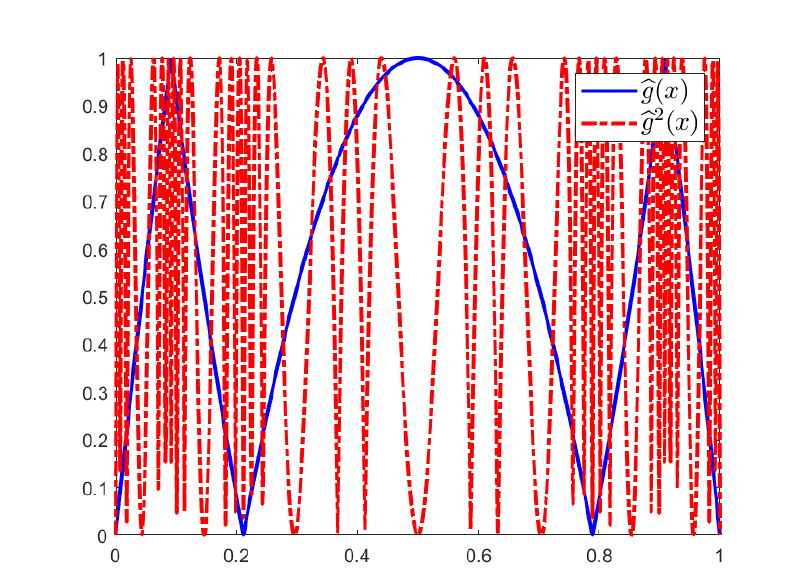
Figure 1. The function images of (cid:98) g and (cid:98) g 2 .